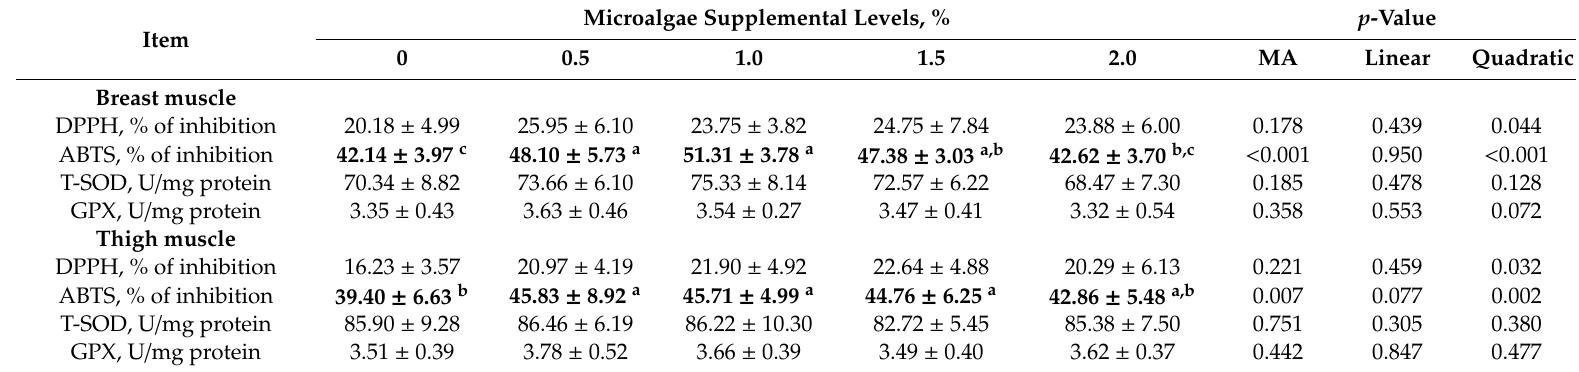
Table 6. DPPH and ABST free-radical-scavenging activity and antioxidant enzyme activity of fresh breast and thigh muscles in laying hens with graded levels of Aurantiochytrium sp. supplementation.